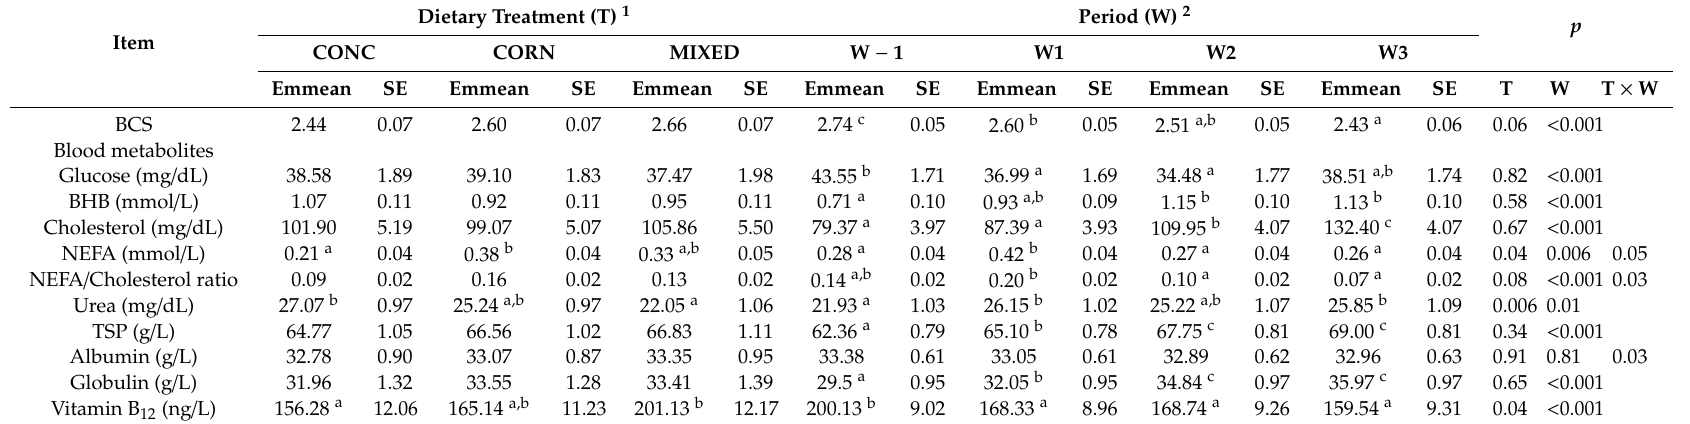
Table 4. E ff ects of the three dietary treatments given during the dry period on the body condition score (BCS) and blood